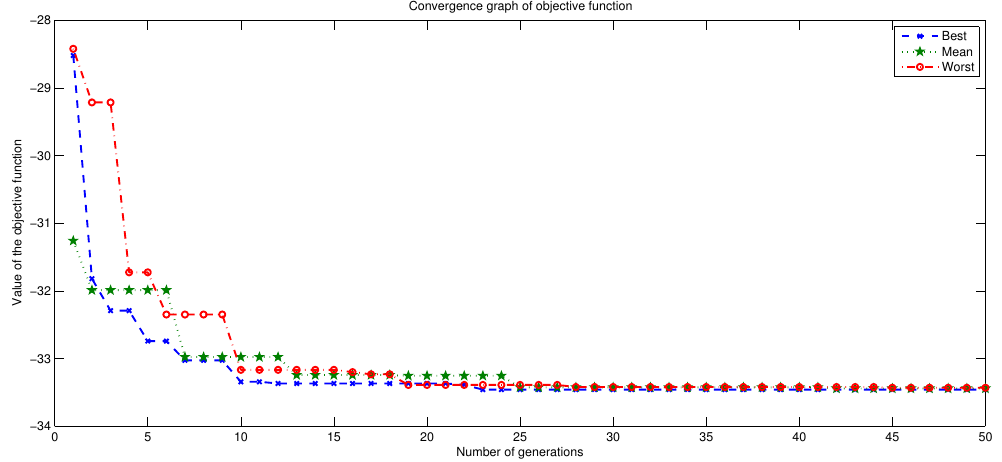
Figure 6. Convergence graph of the objective function for the input filter. Table 2. Table of the results from the statistical analysis. Parameter Objective Function (dB)